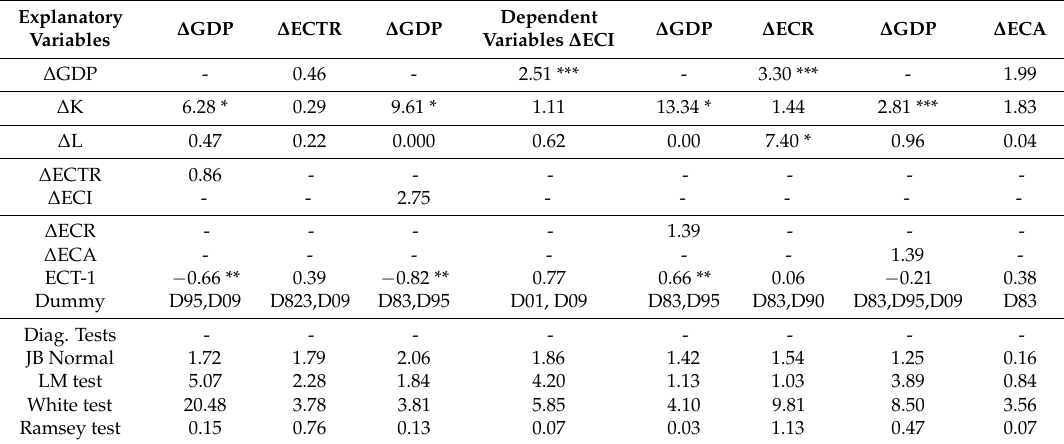
Table 7. Granger causality test results: Disaggregated